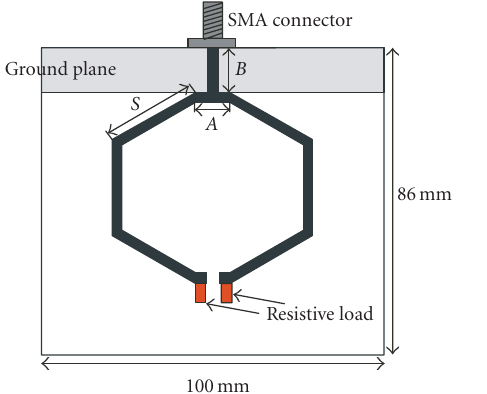
Figure 1: HMS antenna with resistive loading. A = 10 mm, B = 8mm, and S = 28mm.